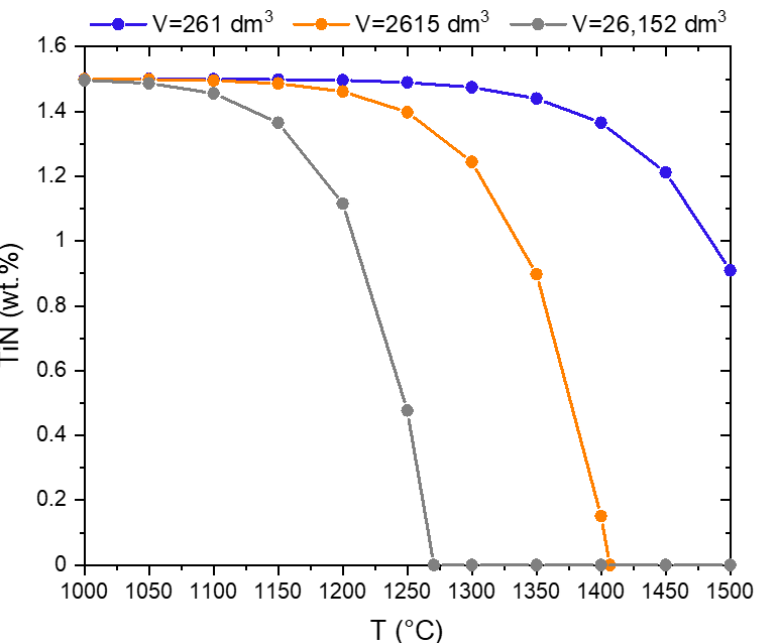
Figure 14. Decomposition of TiN in the mixture of (98.5 wt. % hBN and 1.5 wt. % TiN) according to reaction (2) as a function of temperature and the volume of the system (volume given at 1000 °C in (dm) 3 ).